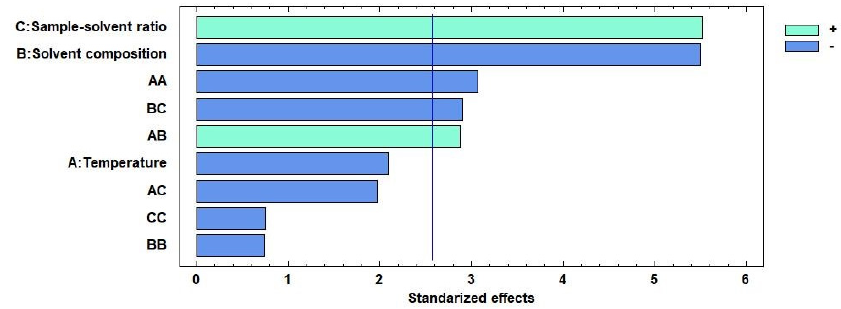
Figure 4. Pareto diagram of the main independent and interaction effects.